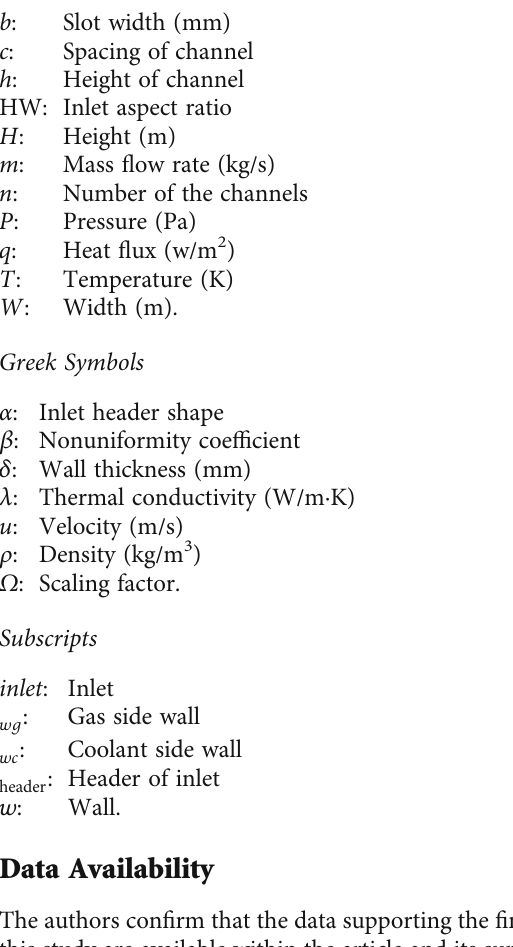
Supplementary Figure 1: thermo-physical property varia- tions of aviation kerosene with temperature. Supplementary Figure 2: the density fi elds in fl uid domain with di ff erent AR values. Supplementary Table 1: viscosity of kerosene at dif- ferent temperatures at P = 3 MPa . (Supplementary